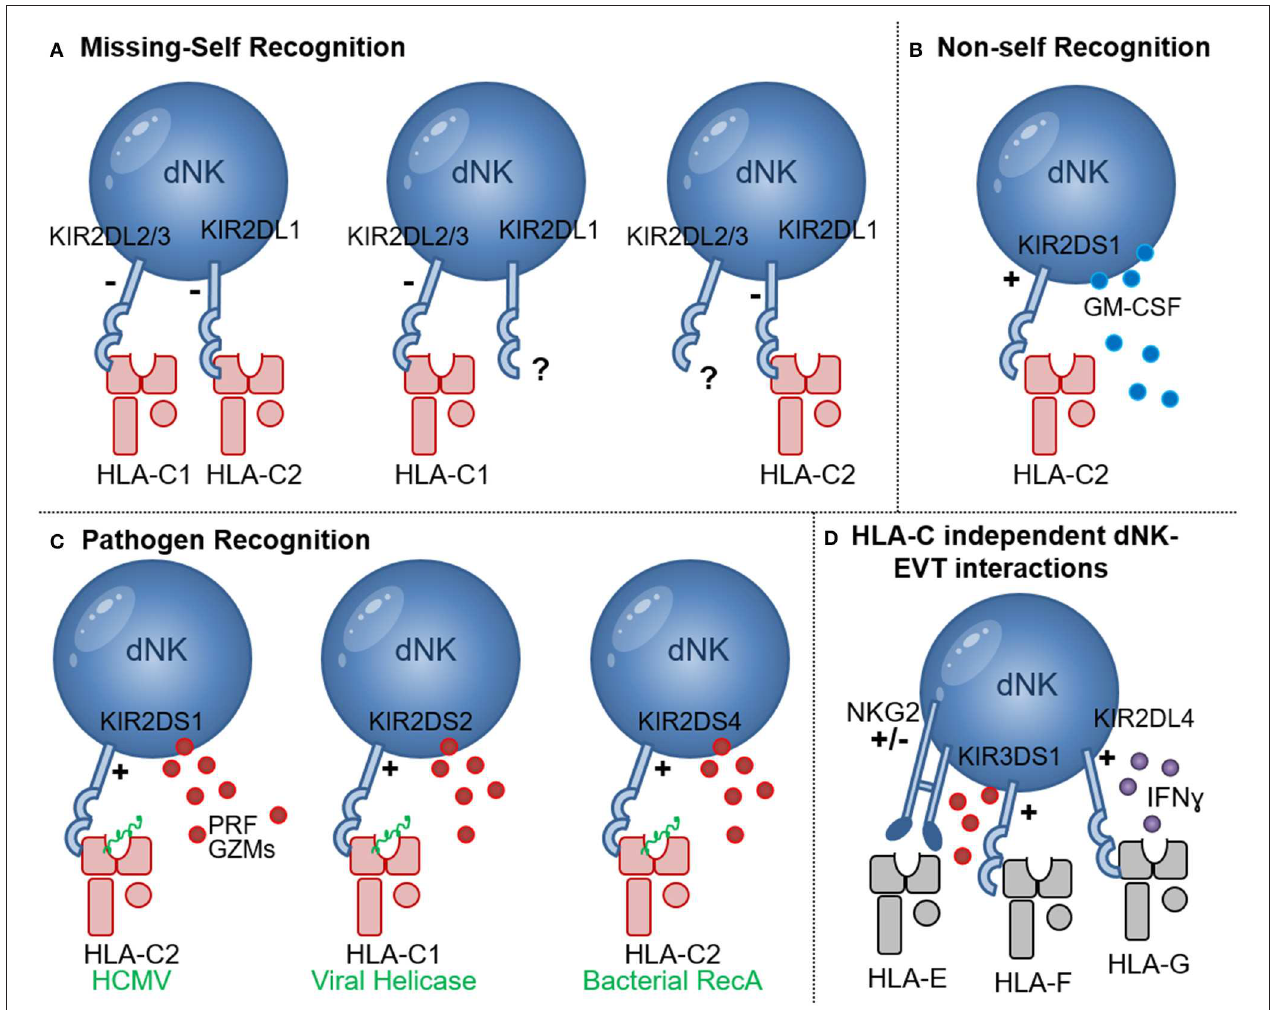
FIGURE 2 | NK cell recognition of HLA-C. (A) Missing-self recognition leads to NK activation when the HLA-C group ligand for a KIR is absent (e.g., when HLA-C2 is absent in the presence of KIR2DL1 or HLA-C1 is absent in the presence of KIR2DL2/3); (B) Recognition of allogeneic HLA-C2 molecules (red) may occur through binding of KIR2DS1 to HLA-C2 molecules. Upon HLA-C2—KIR2DS1 interaction GM-CSF secretion by dNK has been shown; (C) Pathogen derived peptides (green) presented by HLA-C1 and HLA-C2 molecules can activate NK cells expressing the activating receptors KIR2DS1, KIR2DS2, and KIR2DS4 in processes that may enhance NK cytotoxicity, release of perforin (PRF) and granzymes (GZMs) and pathogen clearance; (D) HLA-C independent NK-EVT interactions include HLA-E and NKG2A/C as well as HLA-F and KIR3DS1 interactions that may lead to degranulation and release of perforin (PRF) and granzymes (GZMs). Interaction of HLA-G and KIR2DL4 was shown to inhibit dNK cytotoxicity and promote IFN È